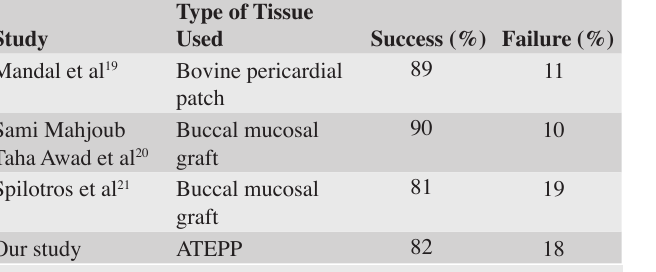
ATEPP, acellular tissue-engineered pericardial